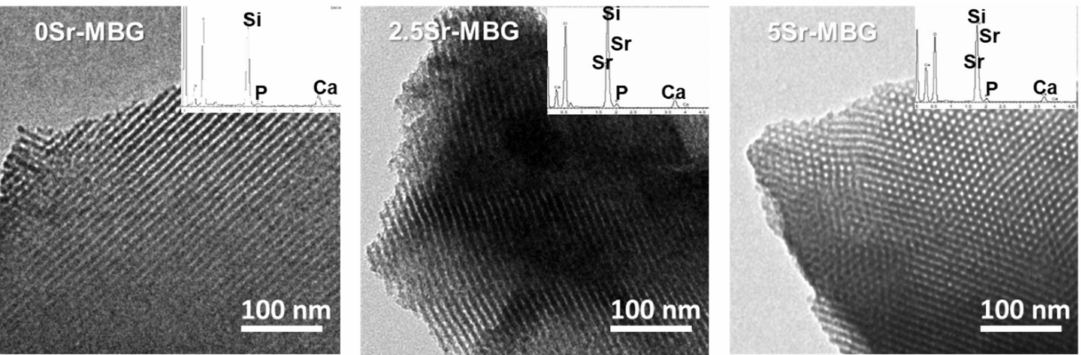
Figure 1. Transmission electron microscopy (TEM) micrographs and their corresponding energy